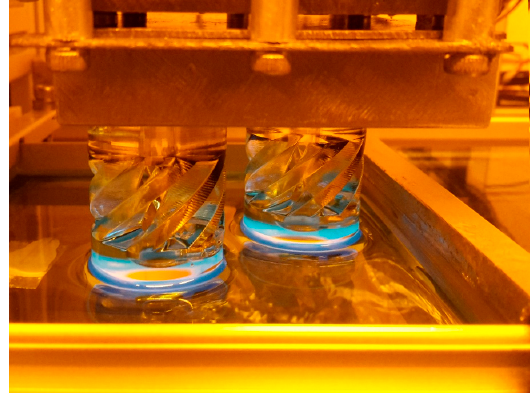
Figure 11. Printing of two shaft couplings with the 405 nm DLP set-up. Moving platform is on top and a transparent vat containing the resin on the bottom.